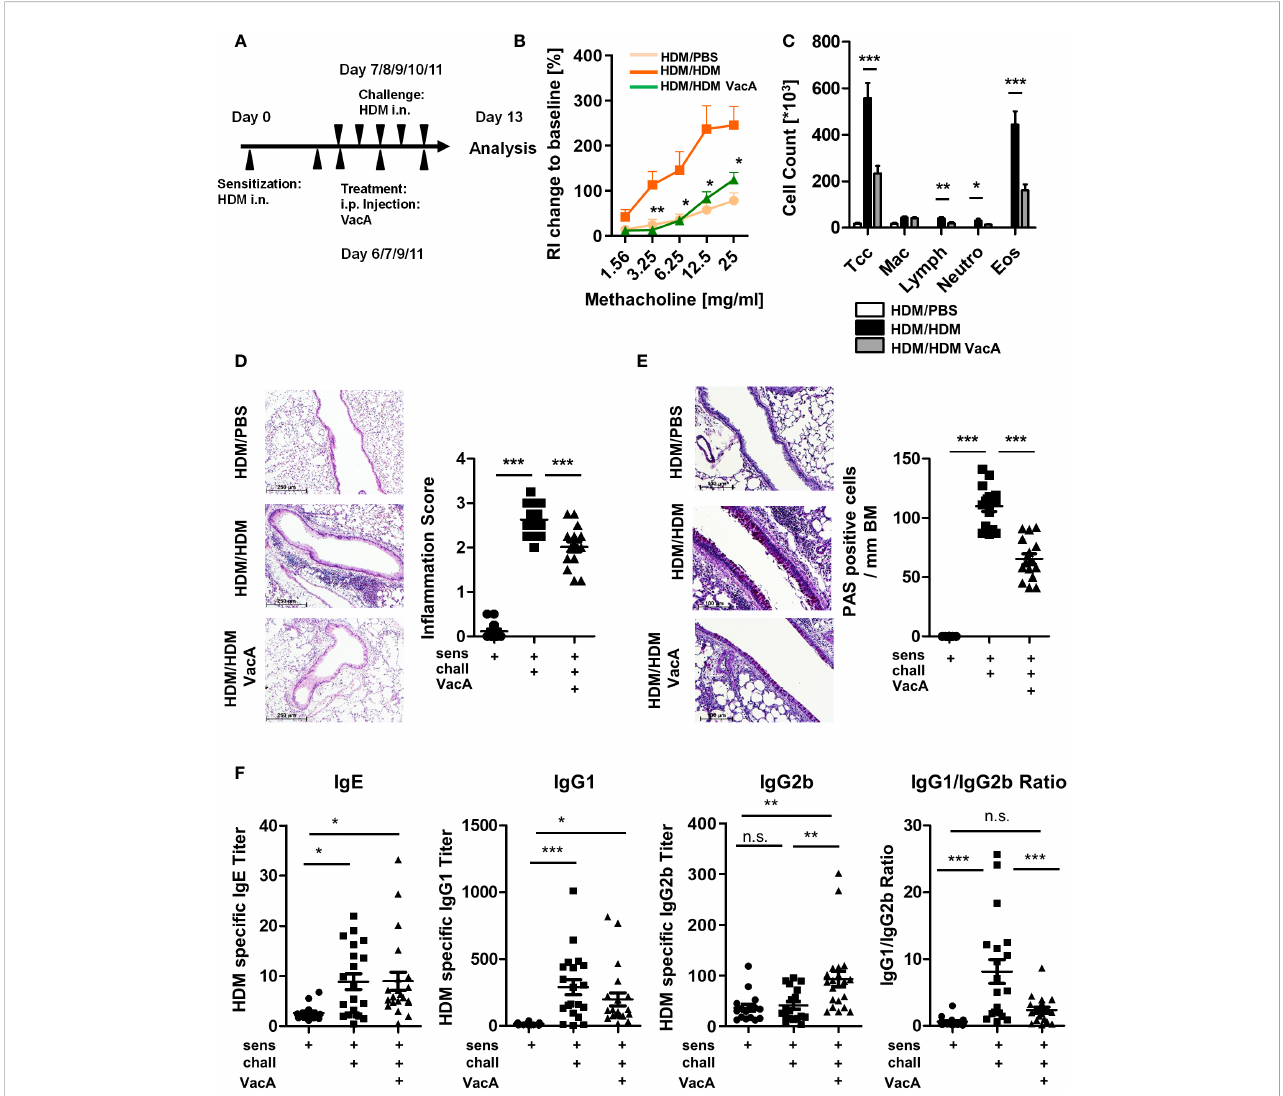
FIGURE 1 VacA treatment attenuates the asthma phenotype. (A) Animals were sensitized (day 0) and challenged intranasally (day 7 – 11) with house dust mite (positive control, HDM/HDM). VacA (HDM/HDM VacA) was given intraperitoneally (i.p.) on days 6, 7, 9 and 11. Phosphate-buffered saline (PBS)-challenged animals served as negative controls (HDM/PBS). (B) Change of airway resistance (RI): percentage change of airway resistance in response to increasing doses of methacholine vs. PBS; HDM/HDM (dark orange), HDM/HDM VacA (green) and HDM/PBS mice (light orange). Asterisks indicate difference between HDM/HDM and HDM/ HDM VacA. (C) Cellular composition of bronchoalveolar lavage (BAL): total cell count (Tcc), macrophages (Mac), lymphocytes (Lymph), neutrophils (Neutros) and eosinophils (Eos); HDM/HDM (black), HDM/HDM VacA (dark gray) and HDM/PBS mice (white). (D) In fl ammation in lung tissue: pictures show representative sections of each indicated group (x100). Scatter plot: in fl ammation score in HDM/PBS, HDM/HDM and HDM/HDM VacA animals. (E) Mucus-producing cells: pictures show representative sections from each group (x200). Scatter plot: number of mucus-producing cells/mm basement membrane in HDM/PBS, HDM/ HDM and HDM/HDM VacA animals. (F) VacA treatment affects immunoglobulin subtypes. Graphs: house dust mite (HDM)-speci fi c immunoglobulin (Ig)E, -IgG1, -IgG2b titers and ratio of HDM IgG1 to IgG2b in HDM/phosphate-buffered saline (PBS), HDM/HDM and HDM/HDM VacA animals. (B, C) results from fi ve independent experiments, n=15 – 20 per group. (D – F) each symbol represents one animal. (D, E) results from four independent experiments, n=12 – 16 per group. (F) Results from fi ve independent experiments, n=16 – 21 per group. Analysis of variance: *p<0.05, **p<0.01, ***p<0.001; ns, not signi fi